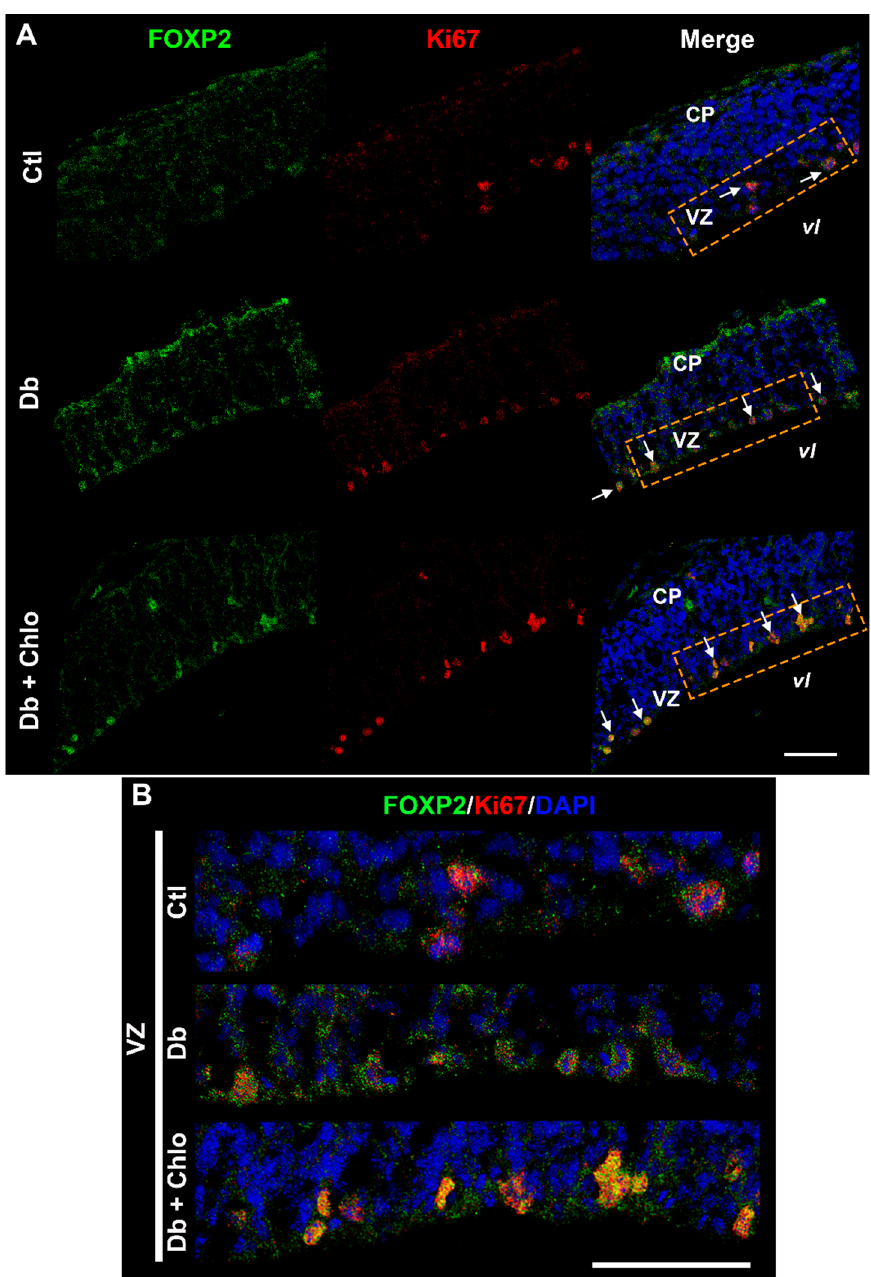
Figure 3. FOXP2 and Ki67 co-localization in the cortical neuroepithelium at 14-day-old embryos. ( A ) Single and merge channels from representative confocal micrographs (40×) of FOXP2 (green), Ki67 (red), and nuclei stained with DAPI (blue) taken from the dorsal telencephalon of E14 of control (Ctl), diabetic (Db), and chlorpheniramine-treated diabetic (Db + Chlo) groups (arrows are FOXP2 and Ki67-positive cells). ( B ) Electronic zoom (300%) from the ventricular zone (VZ) of the orange dotted line rectangle in the merge images in ( A ). Scale bars in ( A ) and ( B ) = 50 μ m, VZ = ventricular zone, and vl = ventricular lumen.